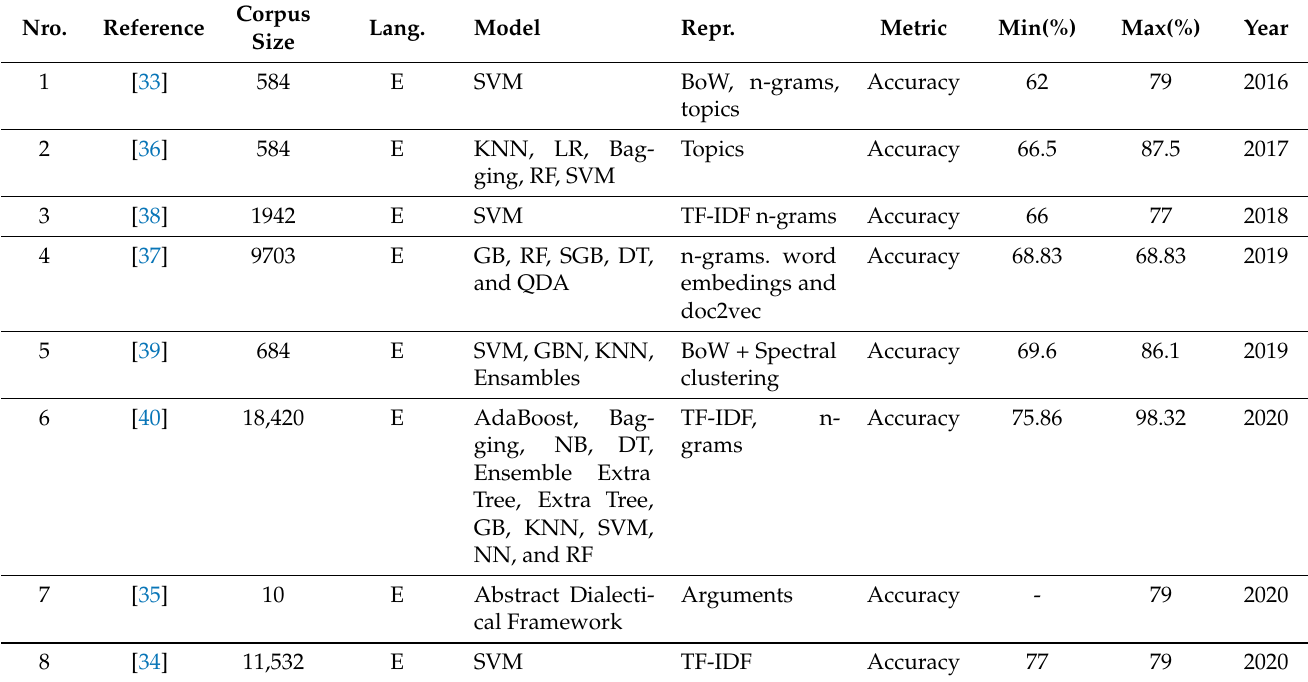
Table 3. Summary of ruling decision prediction in Human Rights, where E =